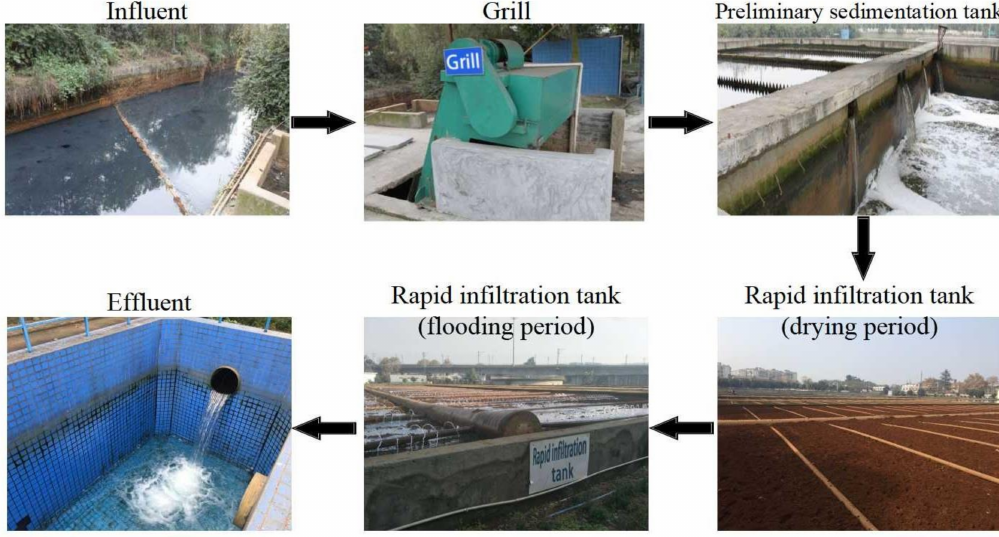
Figure 1. Practical engineering of the Phoniex River constructed rapid infiltration (CRI) system operated successfully for 12 years in Chengdu,